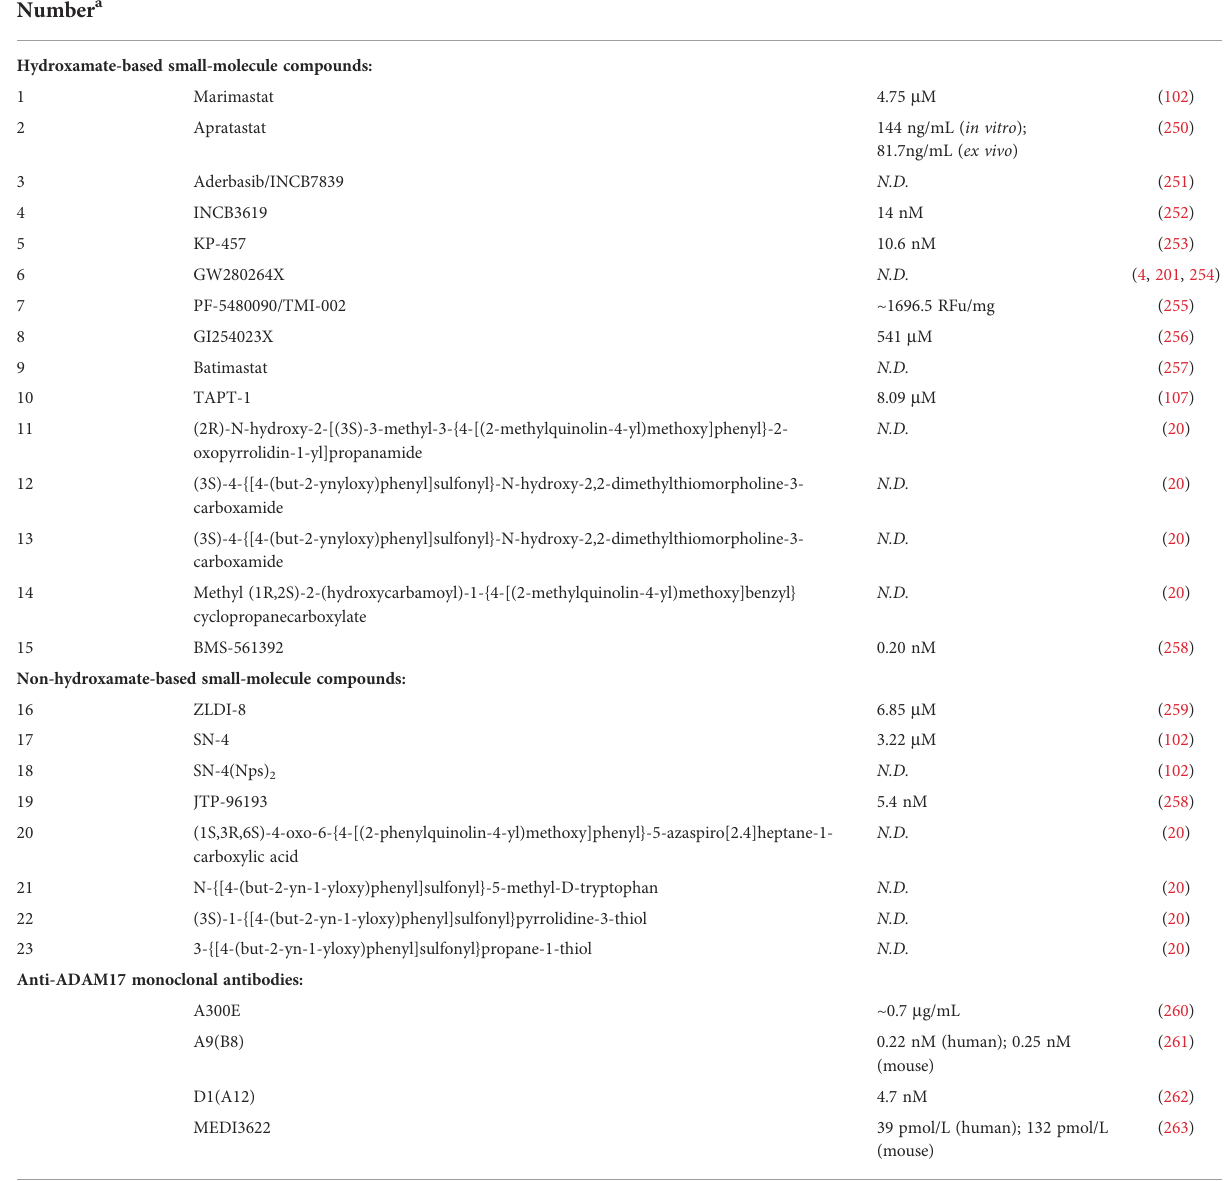
TABLE 2 Summary of the inhibitory activities of ADAM17